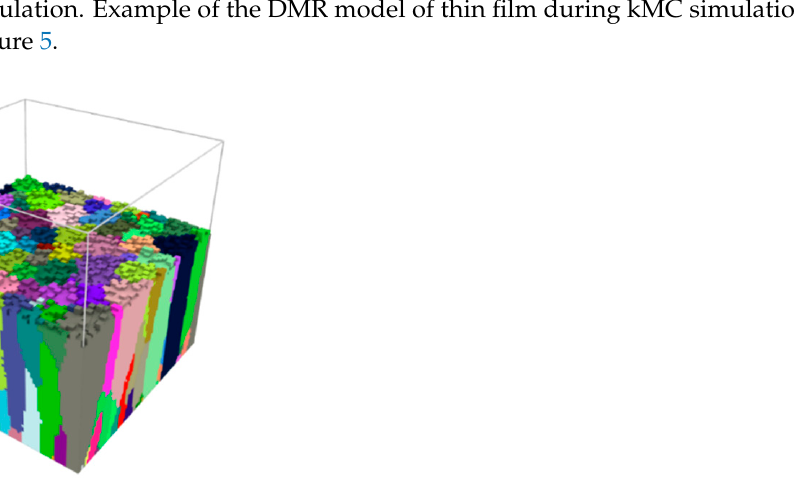
Figure 5. Microstructure morphology during the kMC simulation of the TiN thin film deposition. As presented in Figure 6, the shape of generated columns in the thin films is highly irregular. Bottom columns are characterized by a lower surface area than the columns in the thin film’s upper part. To show a change in the columns’ geometry and the height of the final sample, a surface area of each column at subsequent cross-sections (22, 45, and 67 nm) was calculated and presented in Figure 6.